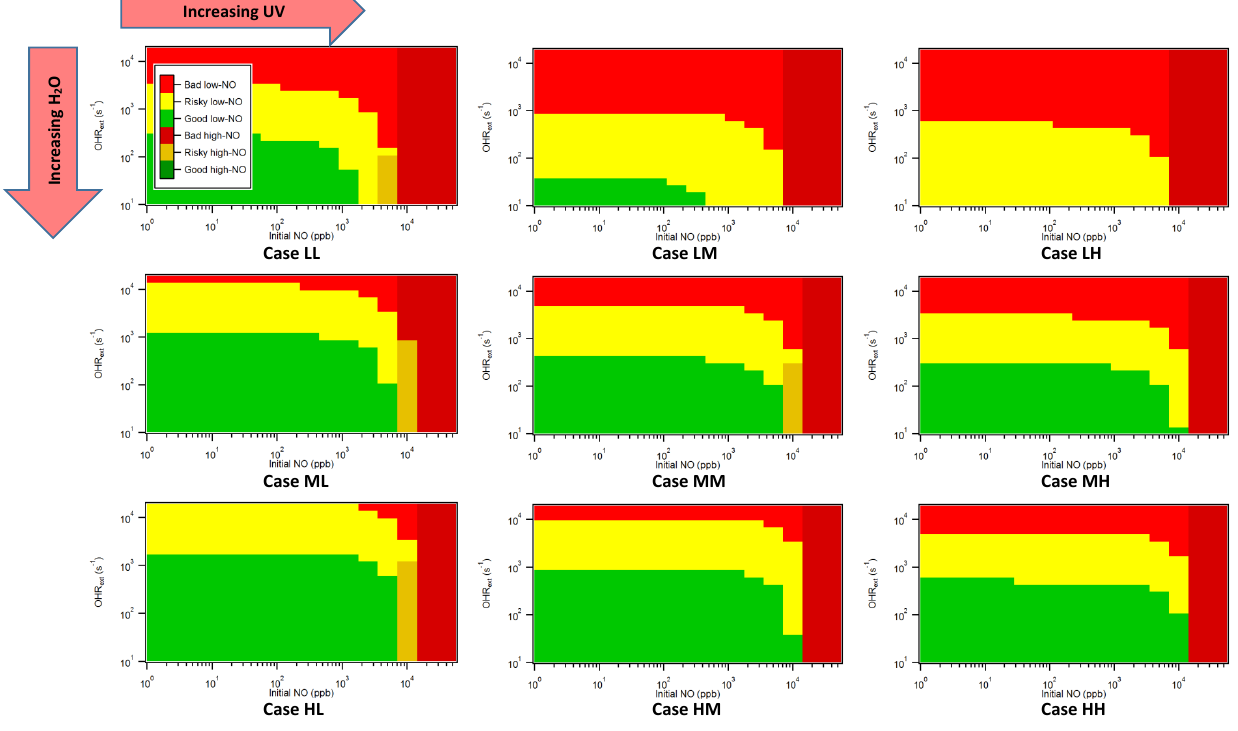
Figure 5. Same format as Fig. 4 but for OFR254-22-iNO.